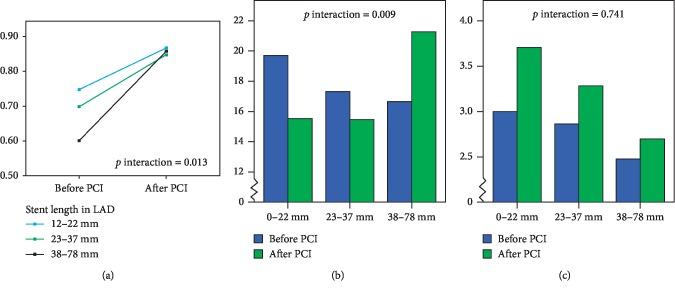
Changes in FFR (a), IMRcorr (b), and CFR (c) before and after PCI in relation to total stent length in LAD.